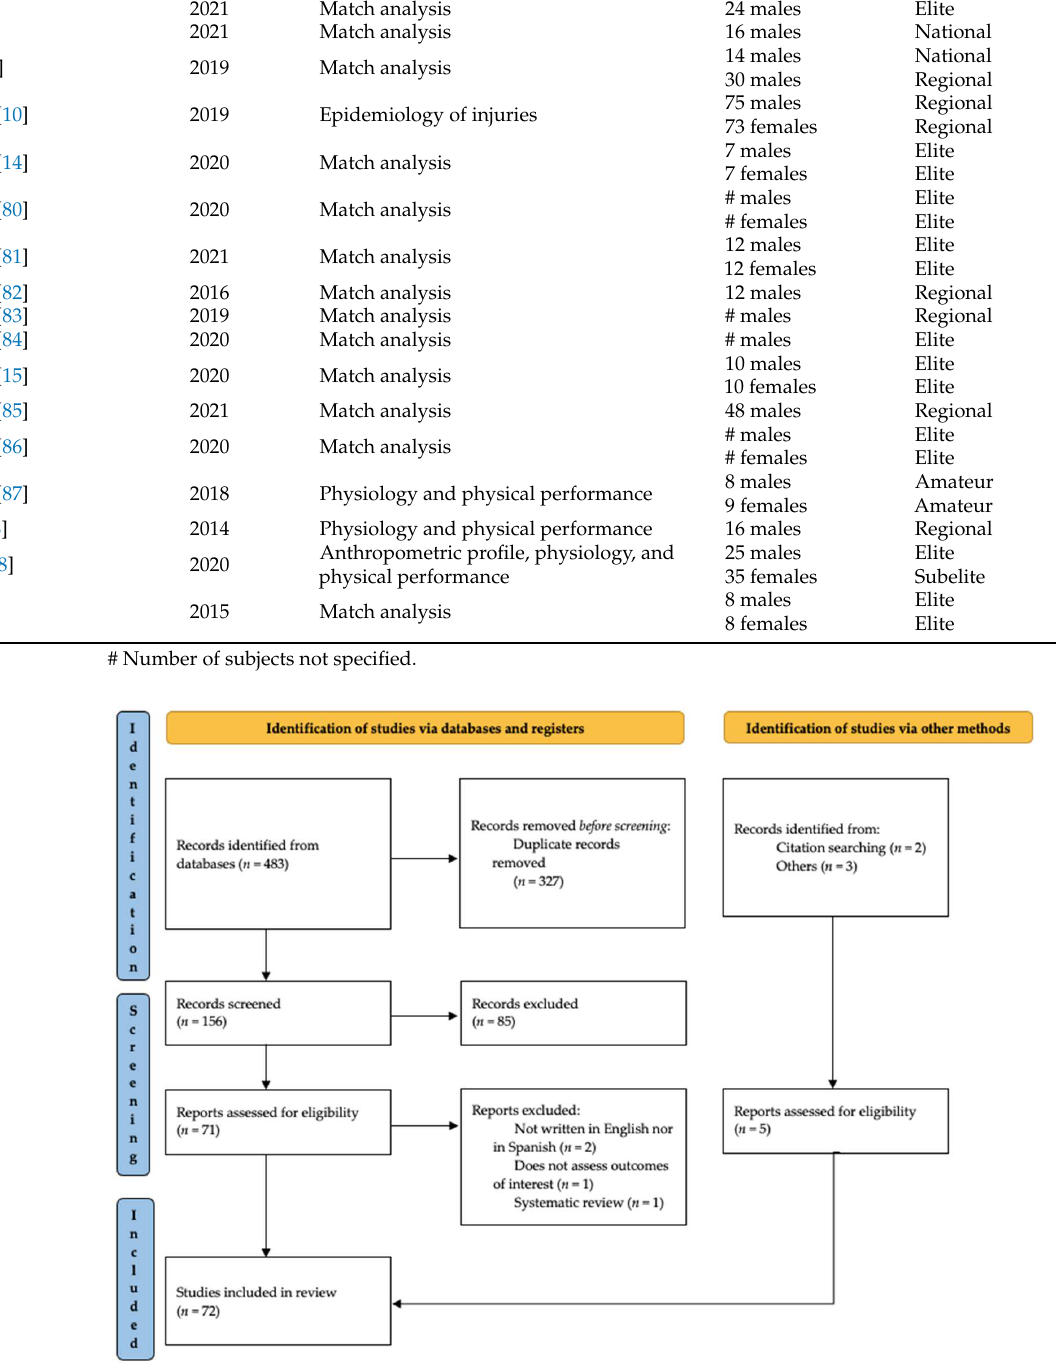
Figure 2. Workflow adapted from the PRISMA statement [27] showing the method to identify and select full-text articles for eligibility. Table 1. Studies included in the review, authors, year of publication, areas of intervention, number, gender, and level of the subjects.